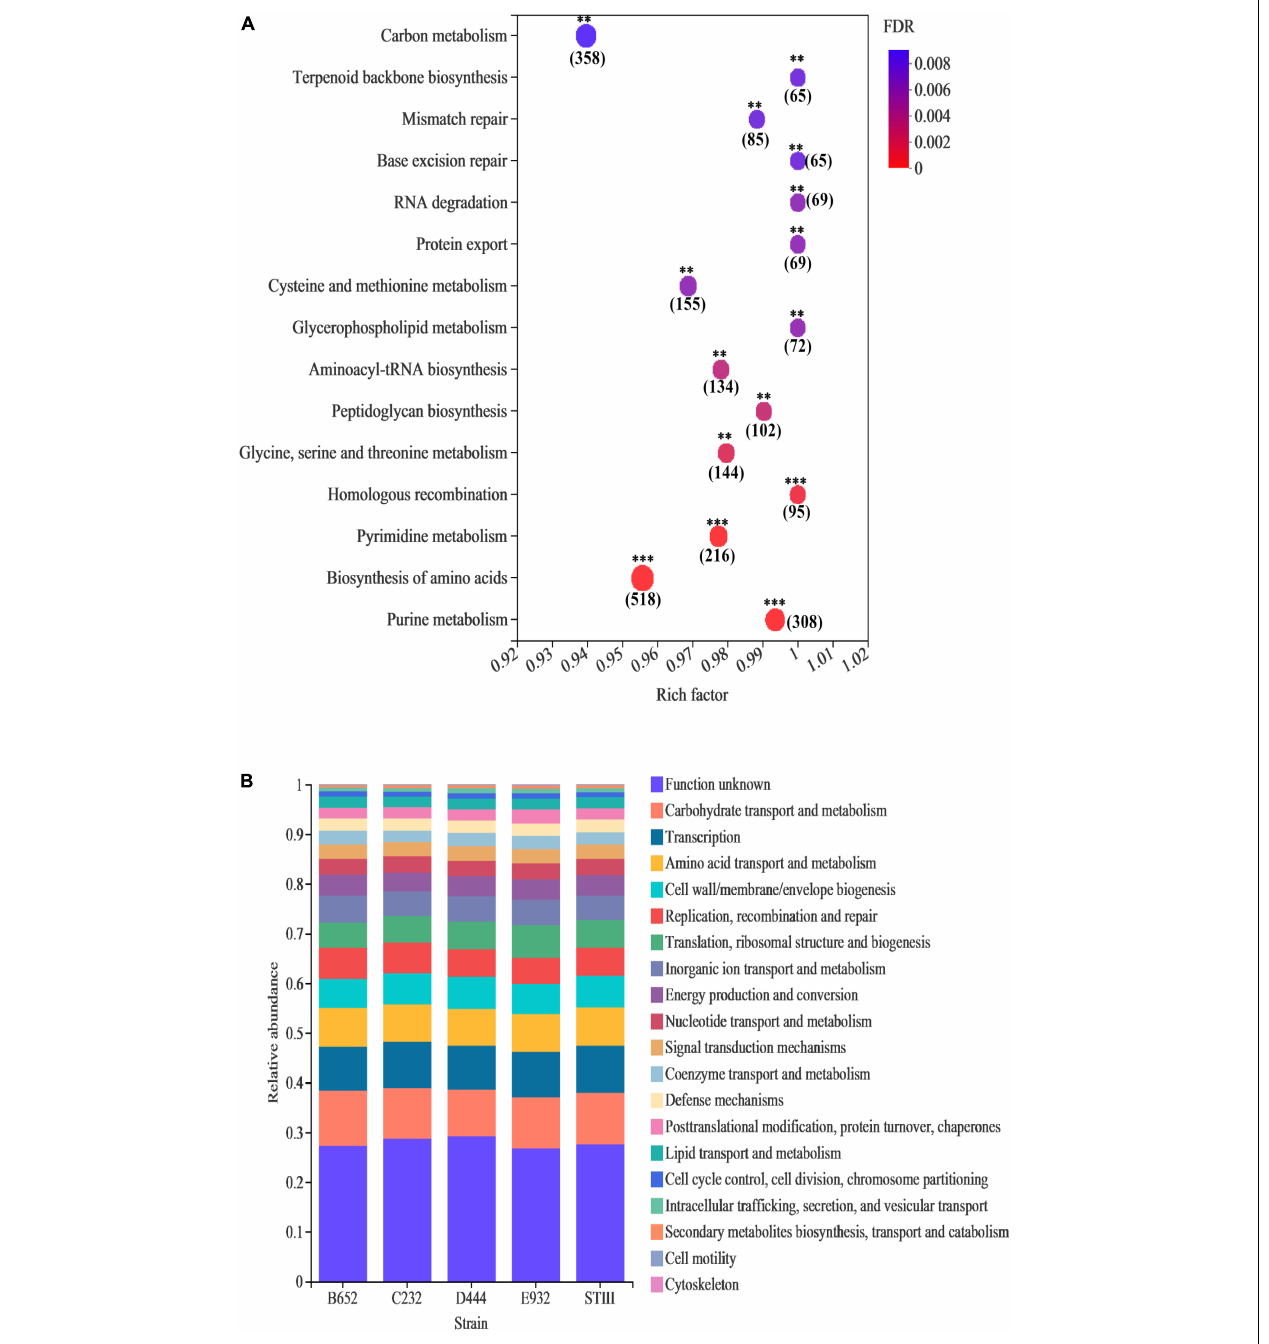
FIGURE 4 | Genomic annotation of the selected L. plantarum strains: (A) enriched genes in KEGG database; (B) genes distribution in core genomes based on COG database. In bubble map (A) , the vertical axis and horizontal axis represent pathways and enrichment rate, respectively. The number indicates the number of genes in this pathway, and the color of the dot indicates the significance level of enrichment. The darker color indicates the more significant enrichment of this pathway, where the false discovery rate (FDR) < 0.001 is marked with ∗∗∗ , FDR < 0.01 is marked with ∗∗ , and FDR < 0.05 is marked with ∗